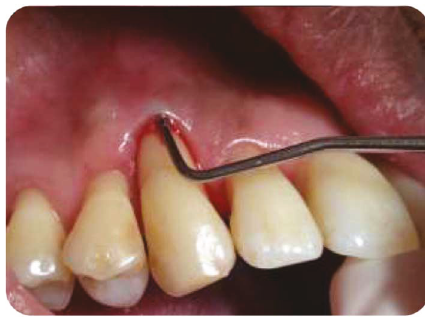
Figure 2: Punctual periodontal probing, 12mm periodontal pocket.